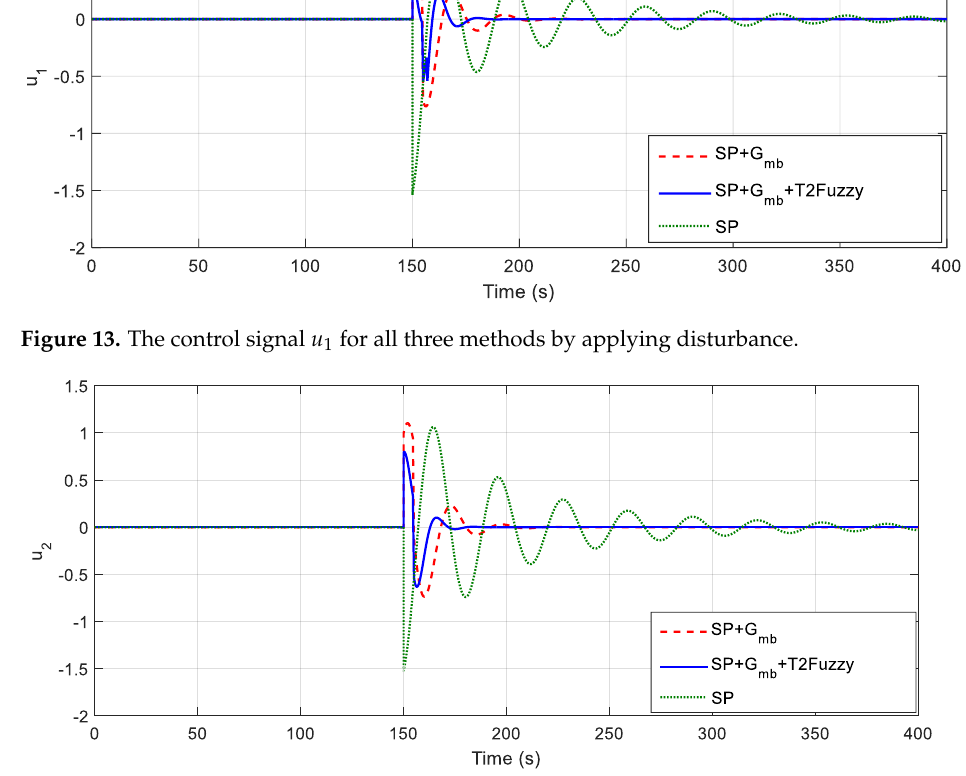
Figure 14. The control signal 𝑢 2 for all three methods by applying disturbance.